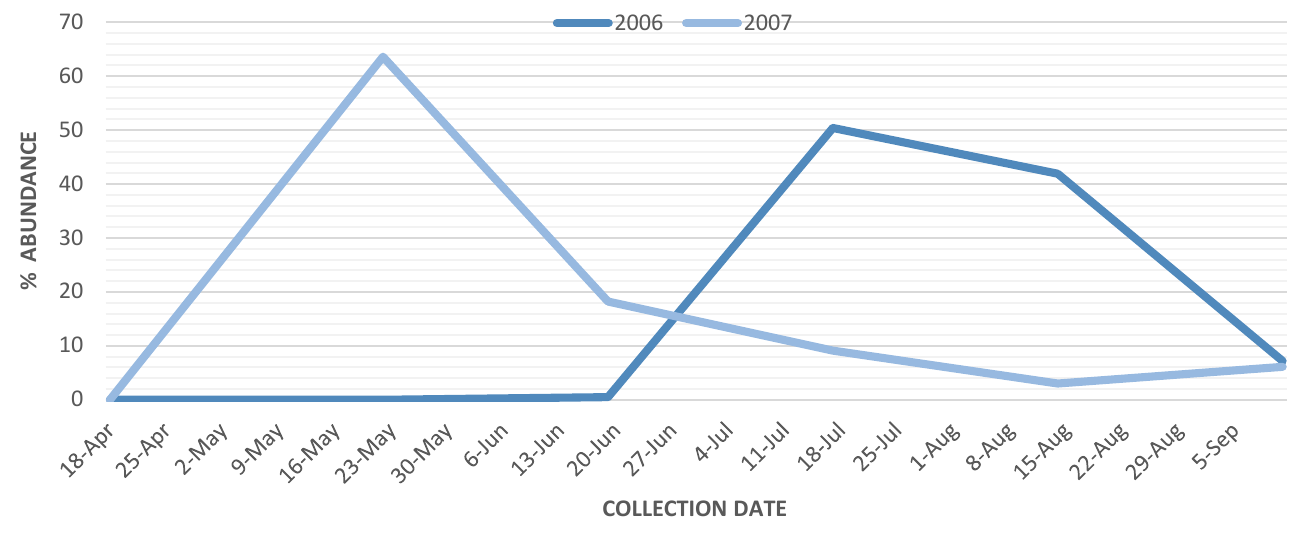
Figure 4. Relative seasonal trap abundance for Psilochalcis quadratis over a two-year period at Utah; Juab County, Yuba Valley. Note that peak abundance shifted two months earlier between years.